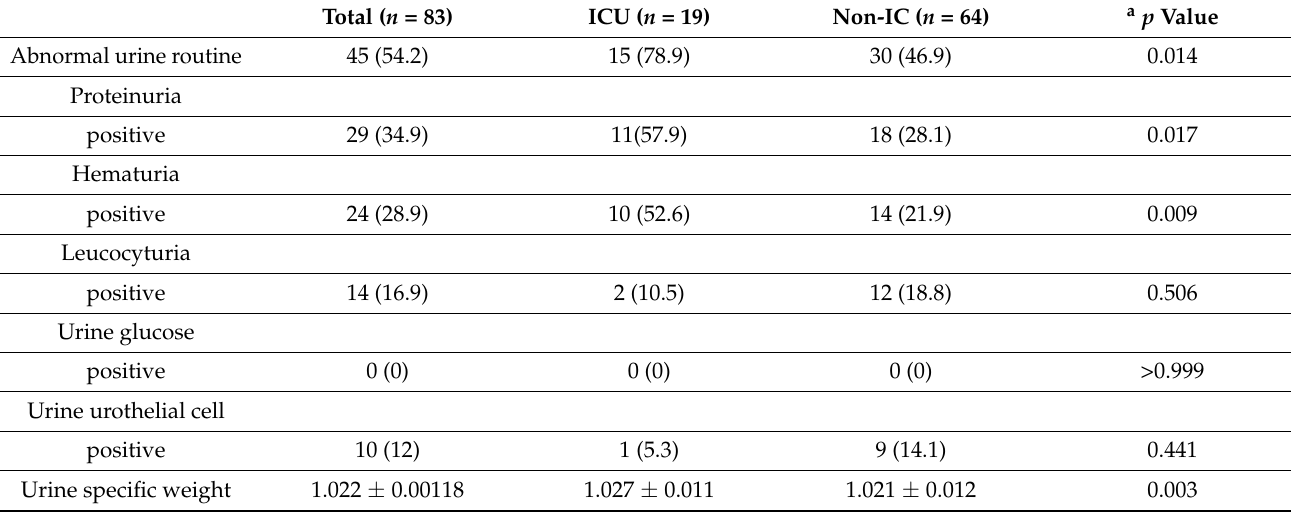
Table 2. Abnormal urinalysis results in COVID-19.